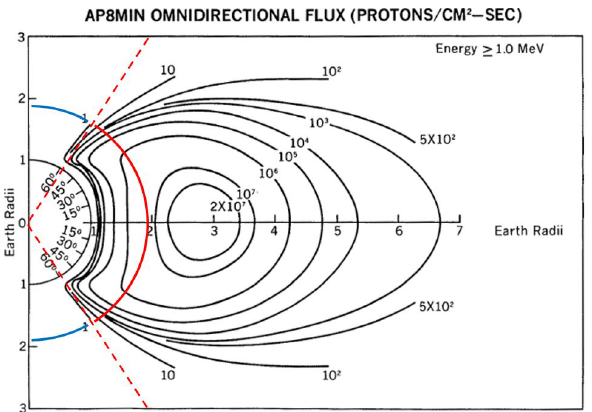
Figure 1. Contour plot of intensity flux for protons [5] and projection of ABCS orbit inside (red) and outside (blue) the inner Van Allen